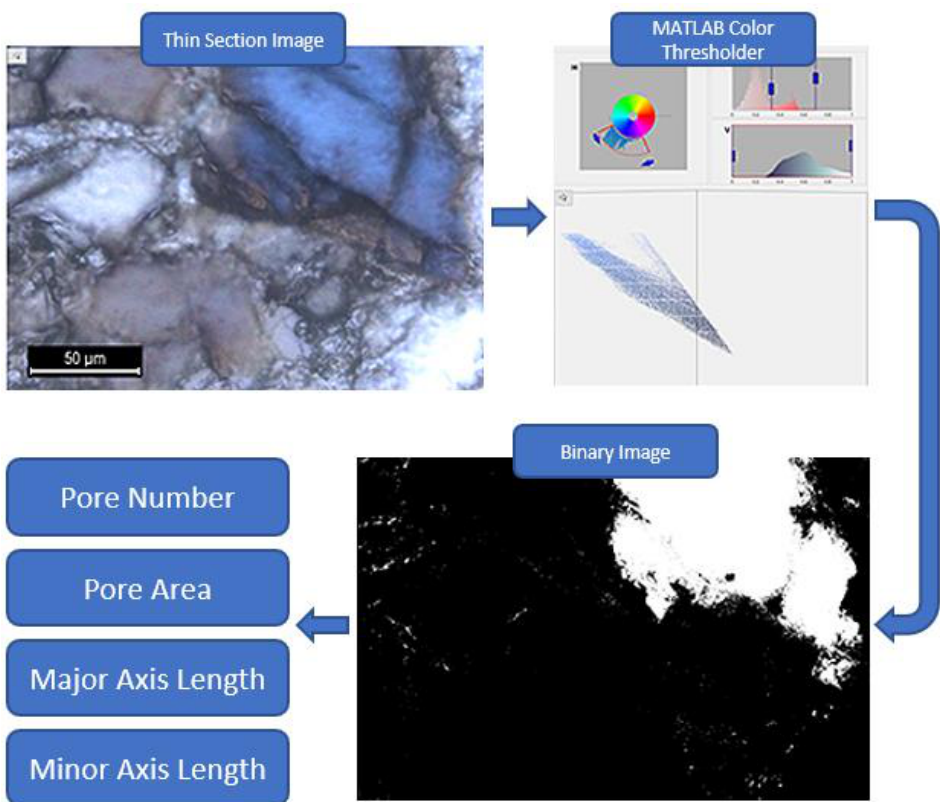
Figure 4. Image analysis workflow diagram for identifying pore spaces in thin sections. The first step is identifying pore spaces based on the color difference using thin sections, the second step is to separate the blue color, the third step is to create a binary images with the 0 value for pore spaces and the 1 value for minerals, and the last step was to classify the clusters of the 0 value spots to calculate their areas, and axes lengths.